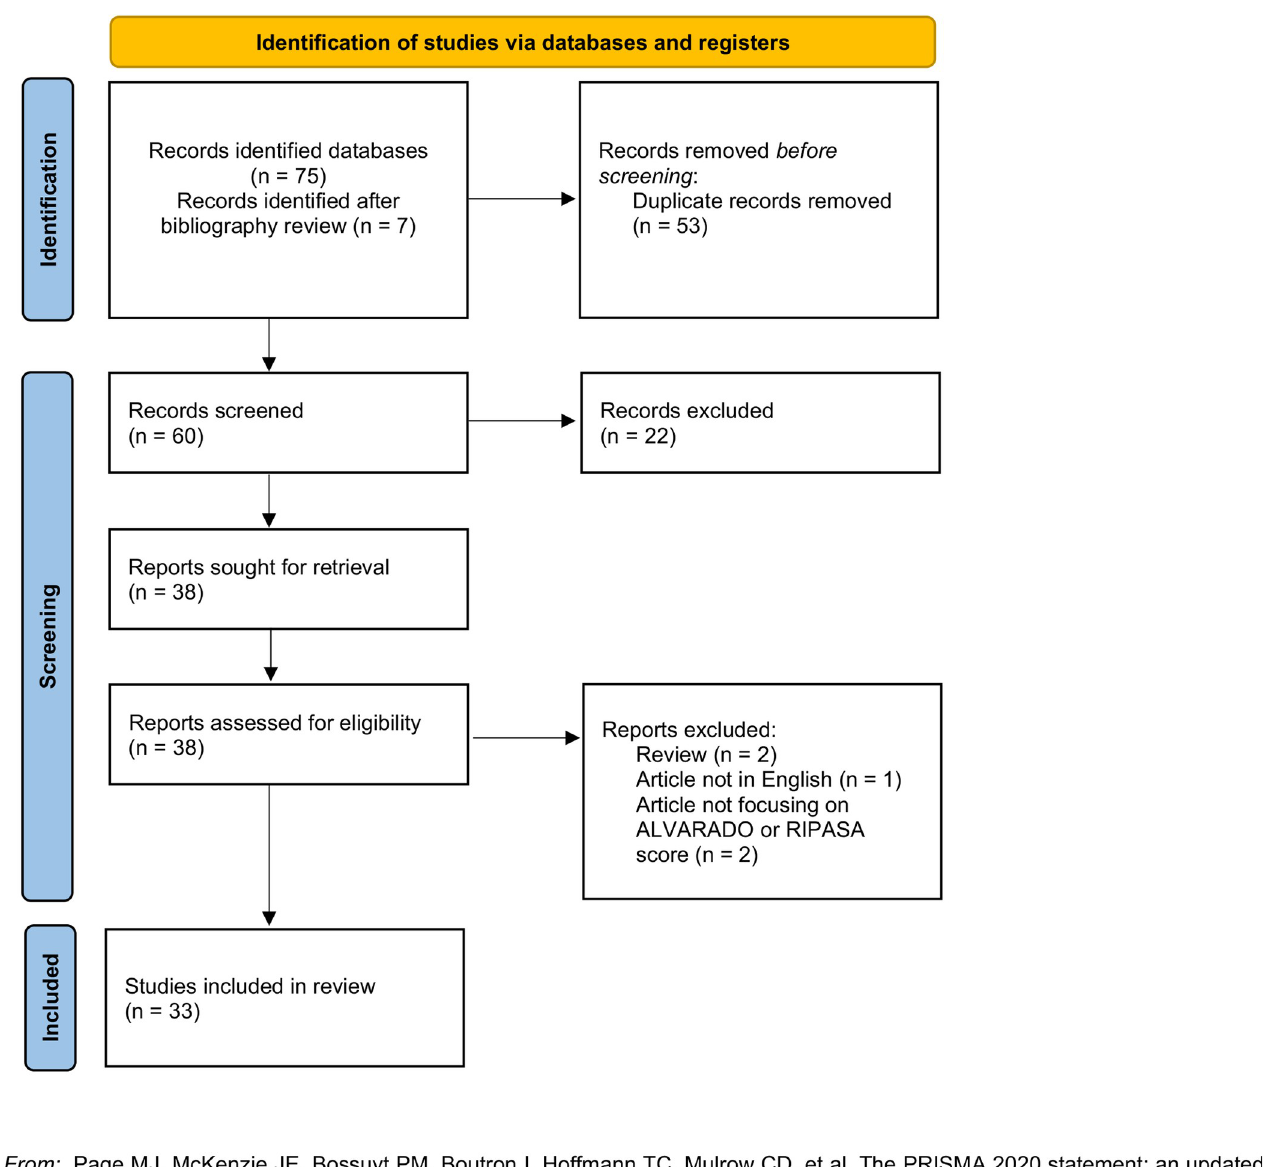
Fig 1. Prisma flow diagram describing study selection